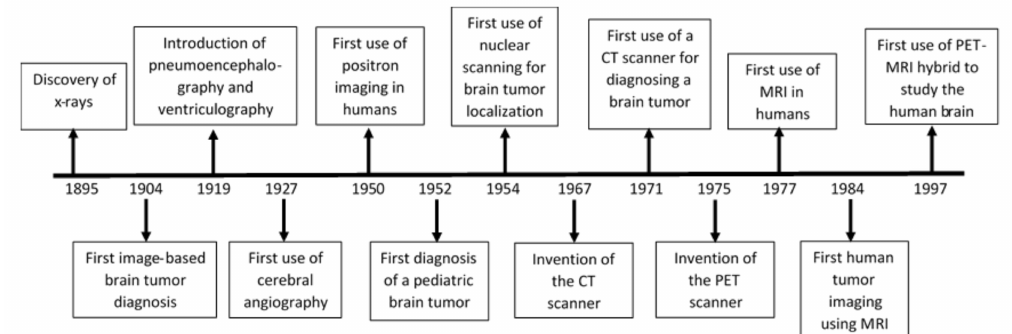
Figure 1. Timeline of important discoveries and events that led to current imaging techniques for detecting glioblastoma (GBM) and other brain tumors. CT, computed tomography; MRI, magnetic resonance imaging; PET, positron emission